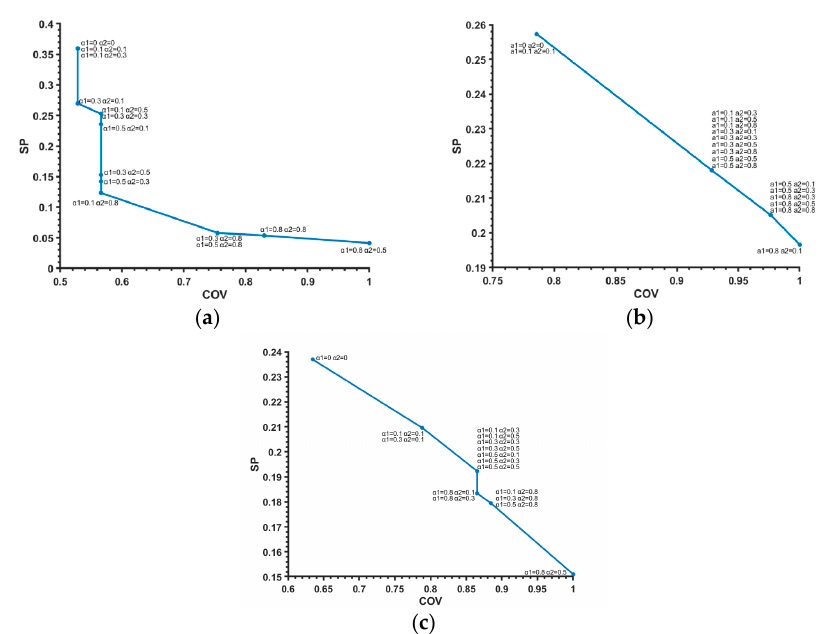
Figure 9. The curves of cov - sp with several pairs of α 1 , α 2 values. ( a ) Cluster 0 ( b ) Cluster 1 ( c ) Cluster 2.